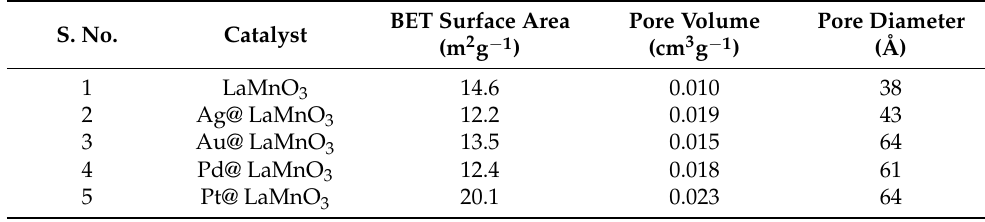
Table 1. Textural properties of the synthesized samples.